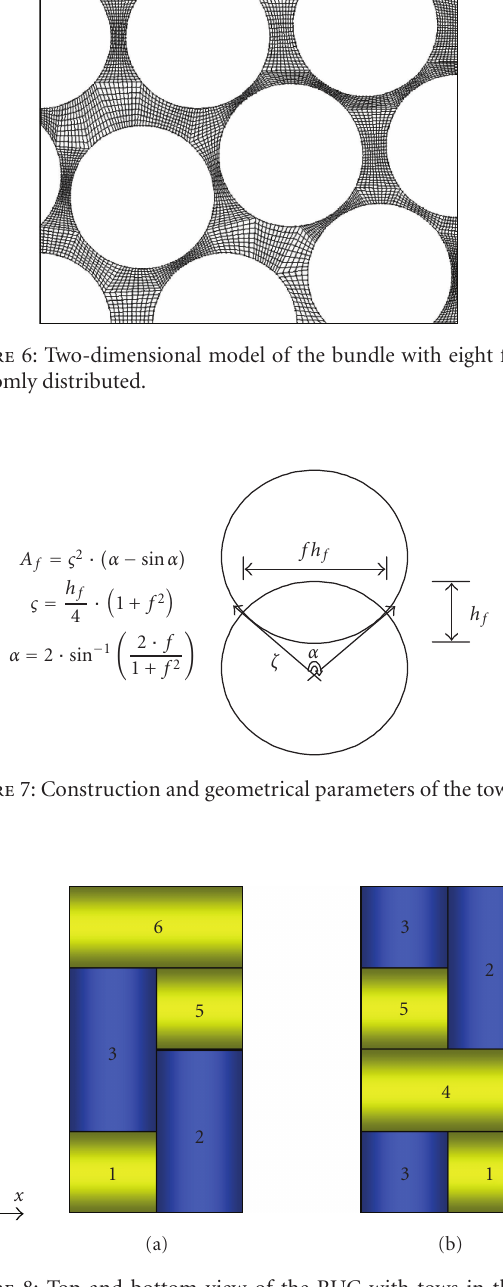
Figure 8: Top and bottom view of the RUC with tows in the y - direction (blue) and in the x -direction (yellow). Numbers indicate the